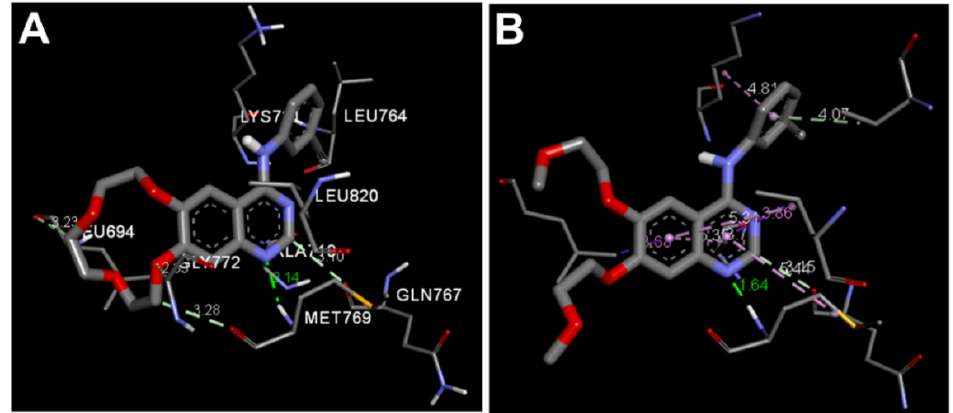
Figure 8. 3D binding mode of erlotinib ( A ), and icotinib ( B ) showing the hydrogen bonds with their bond lengths (Å).